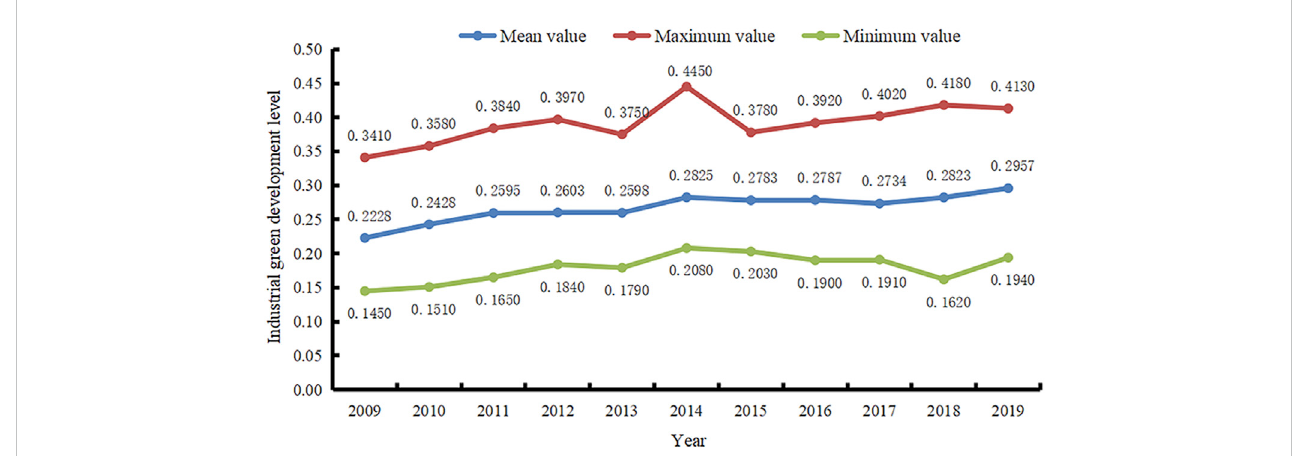
FIGURE 1 The levels of IGDP in China.